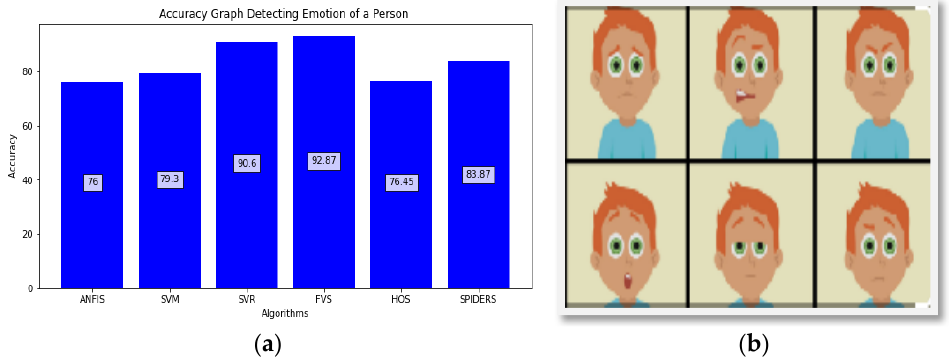
Figure 8. ( a )Emotion of a person accuracy, ( b ) emotion of a person. Table 7. Emotion of a person and hand gesture application.